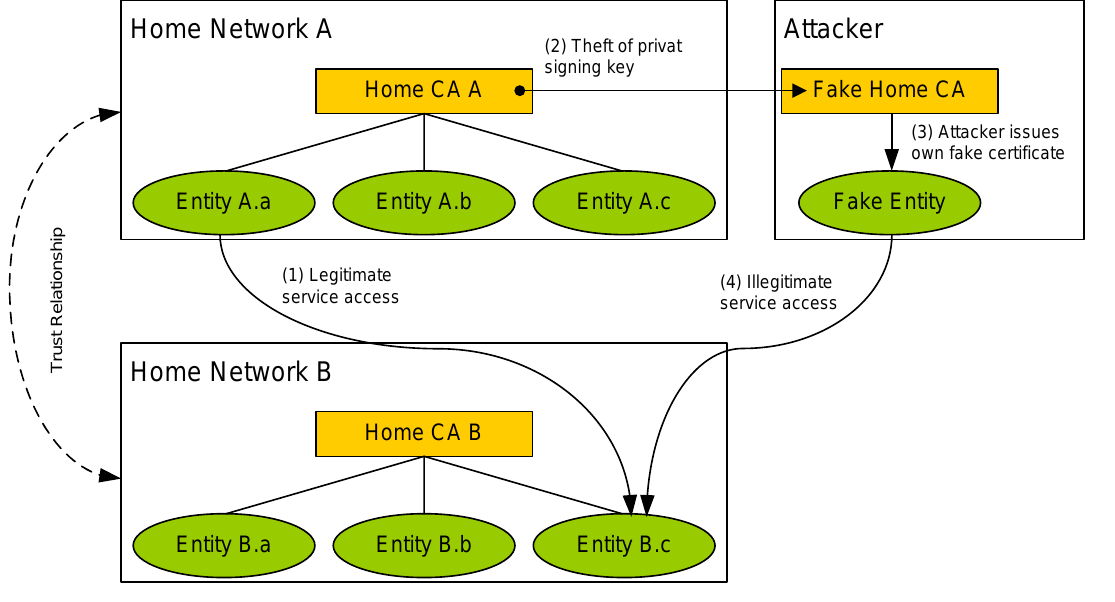
Figure 4. Between home network A and B exists a trust relationship, i.e. , entities from home network A may access services in home network B (1). The attacker succeeds in stealing the Home Key of Home CA A (2). The attacker now is able to issue a certificate to its own entity (3) and later is able to access and abuse the service within home network